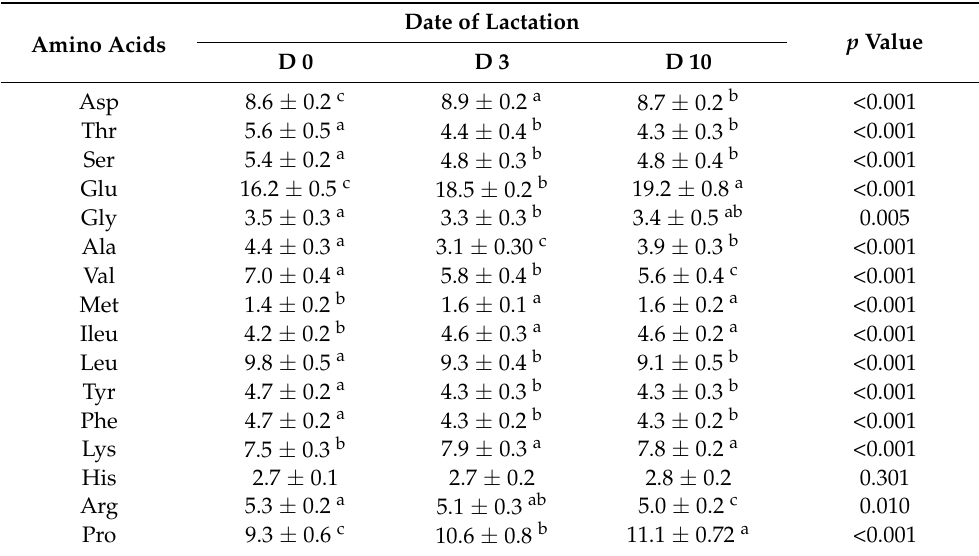
Table 3. Amino acid profile of sow milk at d 0, 3, and 10 of lactation (% of total amino acid, n = 25). Amino Acids